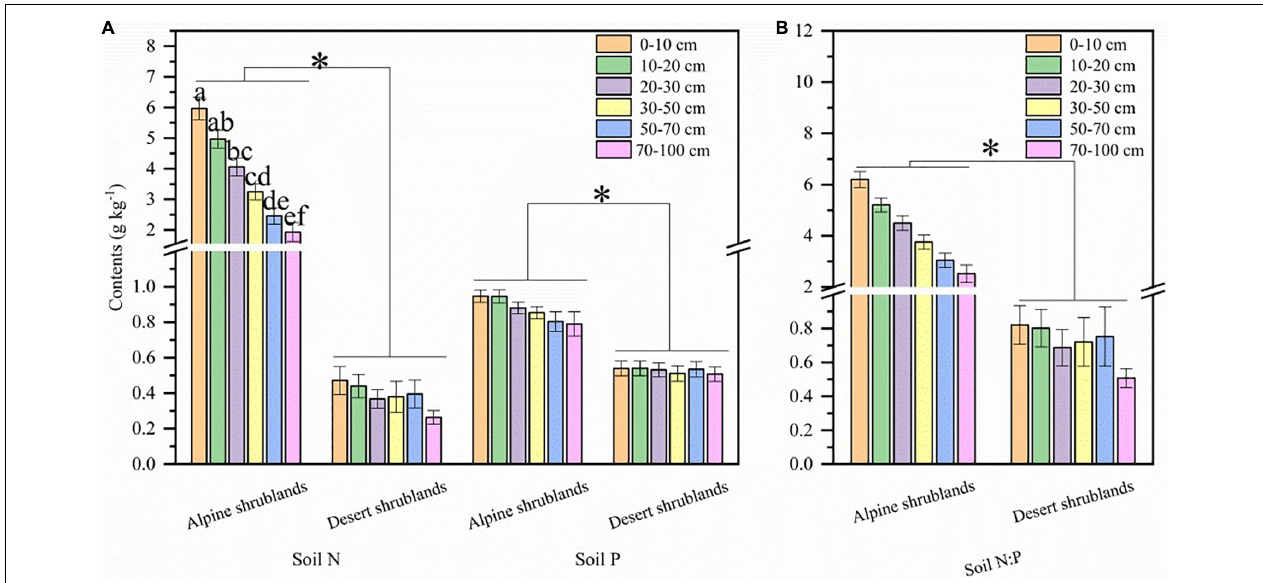
FIGURE 3 | Soil nitrogen (N) content, soil phosphorus (P) content (A) , and soil N:P ratios (B) in different soil depths of 0–10, 10–20, 20–30, 30–50, 50–70, and 70–100 cm. Both “ ∗ ” and different lowercase letters indicate significant differences at the level of P < 0.05. The results are shown as mean values ± standard